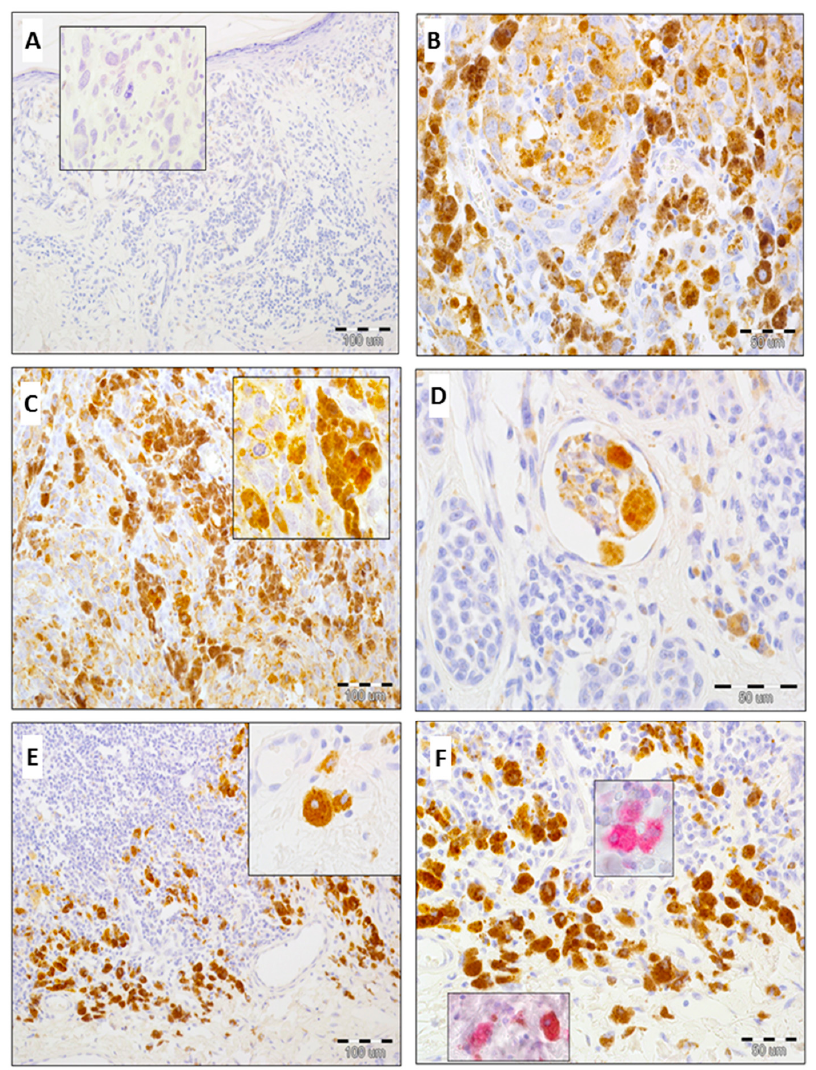
Figure 2. Immunohistochemical analysis of GOLPH2 expression in skin melanoma. Lack of GOLPH2 immunoreactivity in melanoma cells, higher magnification: pathologic mitosis with no GOLPH2 expression (( A ) 100×, 600×, hematoxylin); High cytoplasmic expression of GOLPH2 in neoplastic melanocytes (( B ) 200×, hematoxylin, ( C ) 100×, 600×, hematoxylin); Lymphangioinvasion with a nest of GOLPH2-positive melanoma cells (( D ) 400×, hematoxylin); Strong GOLPH2 expression in tumor-associated macrophages, higher magnification: round cell with a macrophage phenotype, low nuclear/cytoplasmic ratio and strong cytoplasmic GOLPH2 reactivity (( E ) 100×, 600×, hematoxylin); Strong TIL (tumor-infiltrating lymphocytes) infiltration (negative for GOLPH2) at the base of tumor mass and enhanced expression of GOLPH2 in macrophages, higher magnification: immunohistochemical reaction (red chromogen) with anti-CD68 antibody (( F ) 200×, 600×, hematoxylin).